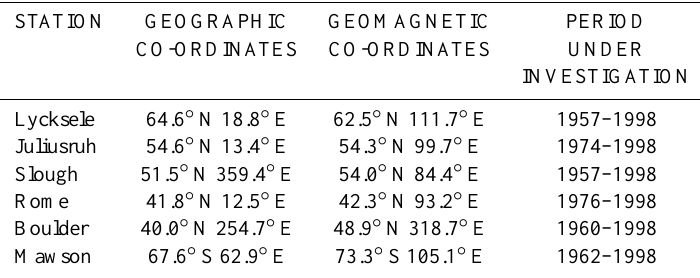
Table 1. The ionospheric observatories under